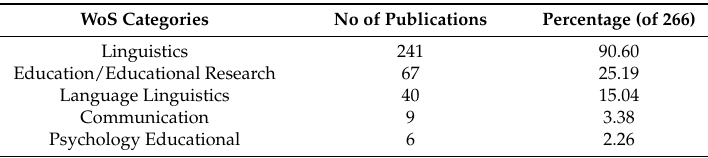
Table 2. Distribution of SLW publications according to WoS categories.